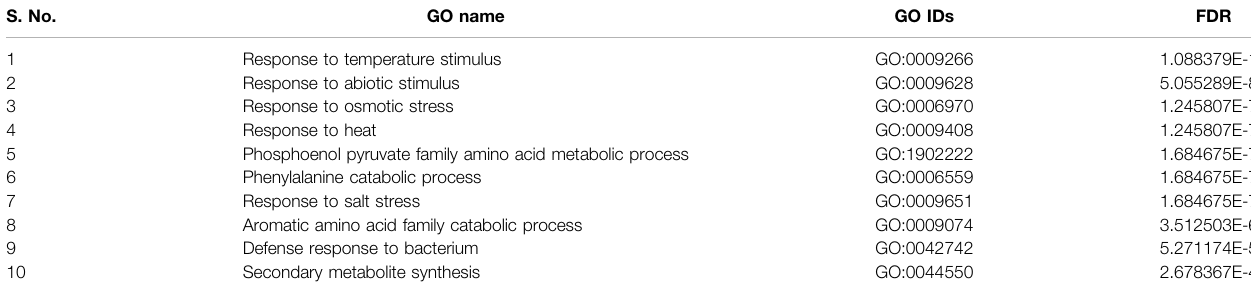
TABLE 4 | List of top 10 biological processes with GO IDs that are overrepresented in upregulated DEGs in root tissues of PBW677. S. No.